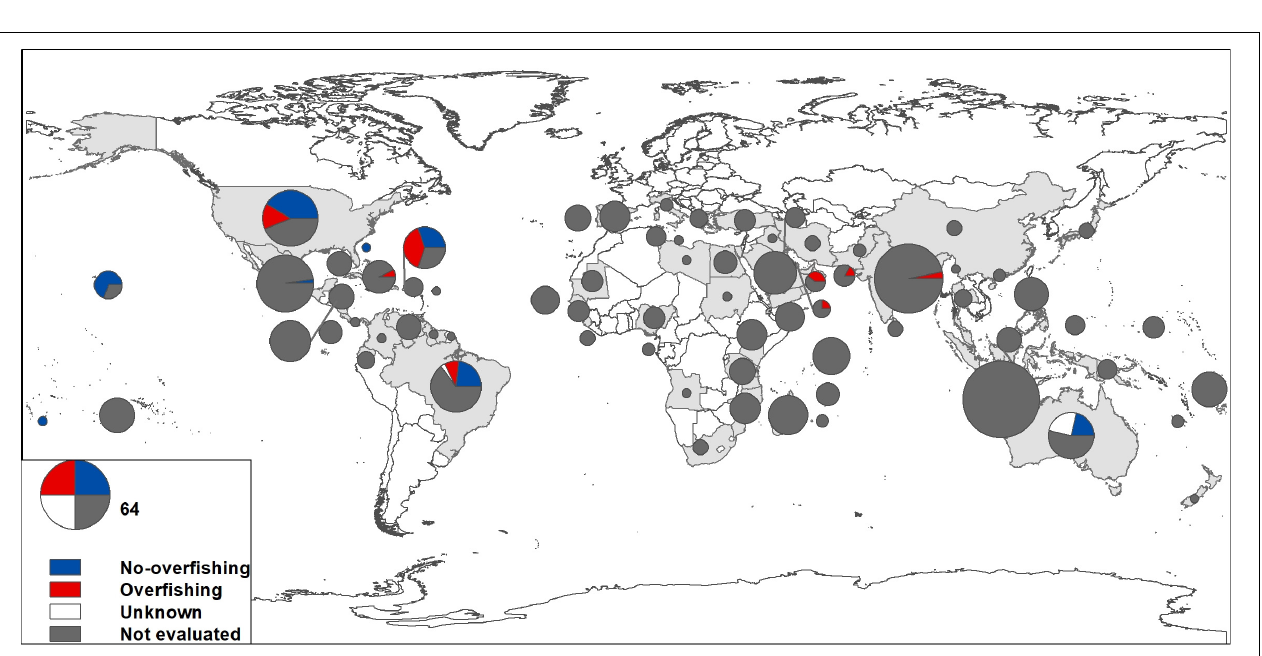
FIGURE 2 | Biomass status classification of snapper and grouper fisheries by country. The shaded countries are those considered in this study, and the sizes of the pie charts are proportional to the number of fisheries by country included in the database.